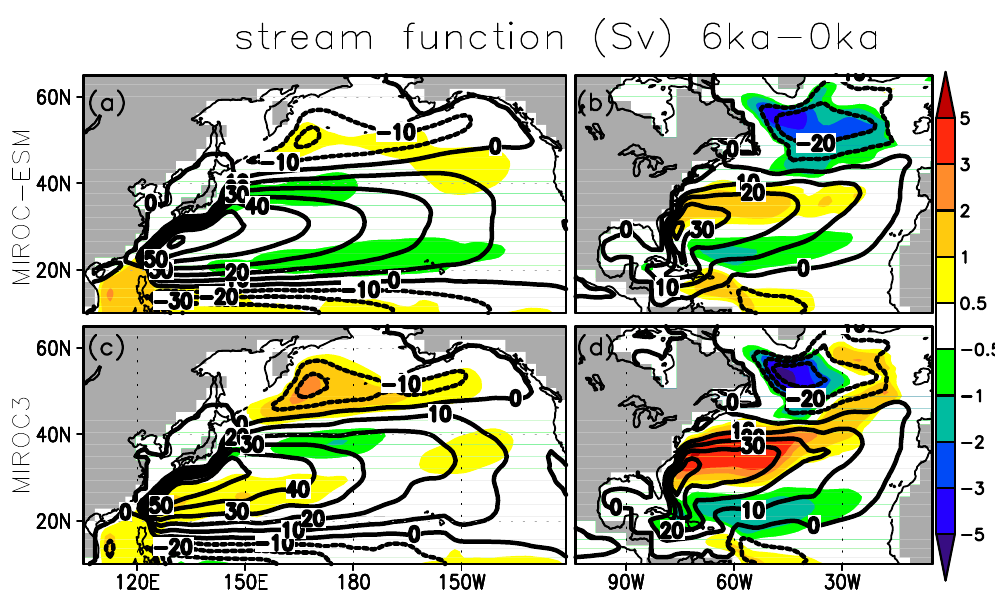
Fig. 9. Ocean surface stream functions (contours for 0ka) and the changes at 6ka (colored shading) (Sv) for the Pacific and Atlantic sectors in the Northern Hemisphere, obtained using (a, b) MIROC-ESM and (c, d) MIROC3.